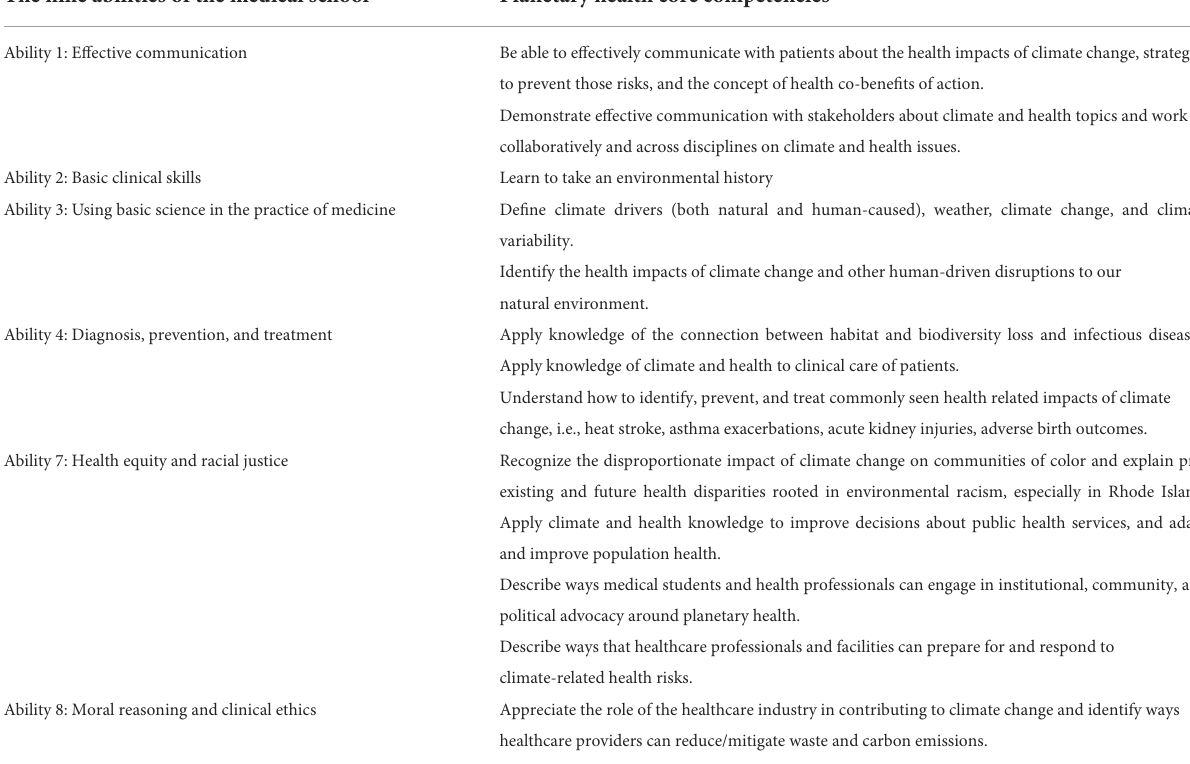
TABLE 1 Planetary health core competencies aligned with guiding educational principles. The nine abilities of the medical